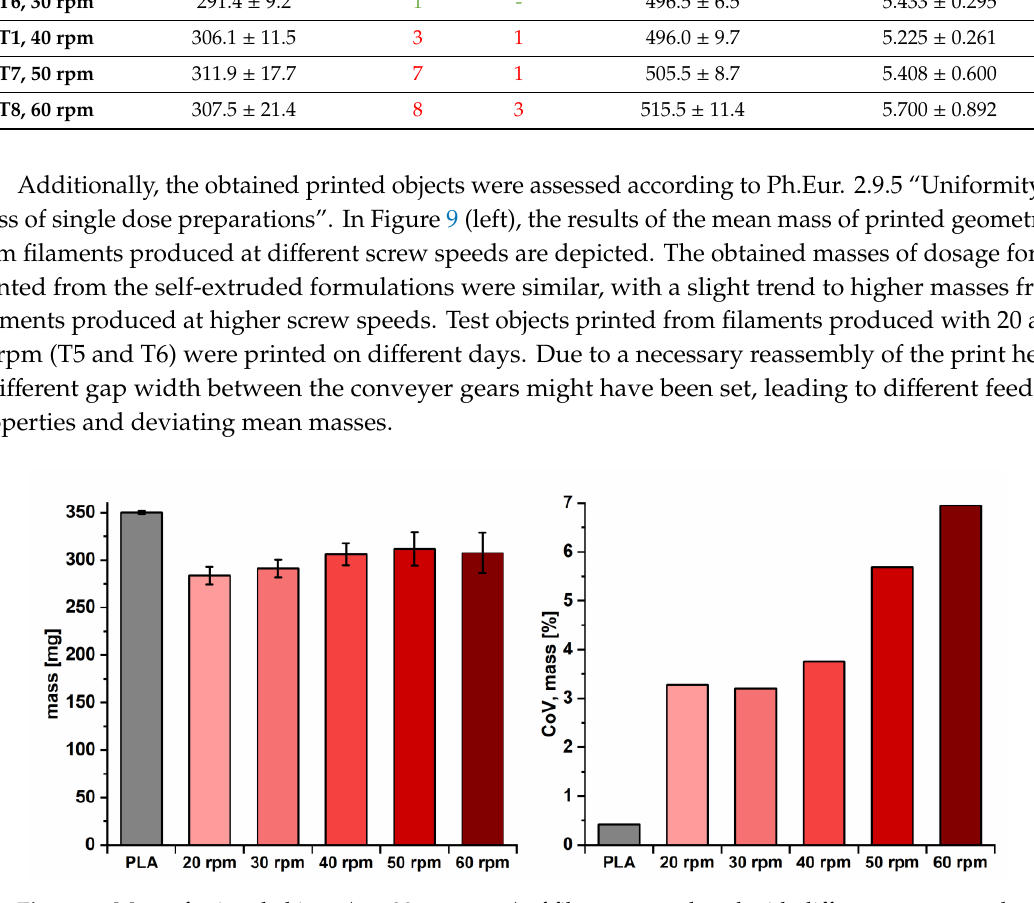
Table 3. Overview of the impact of diameter variations (related to applied screw speeds) on mechanical resilience of filaments and mass uniformity of printed test geometries, as well as results according to Ph.Eur. 2.9.5 (green numbers = corresponded; red numbers = not corresponded; ND = not determined).